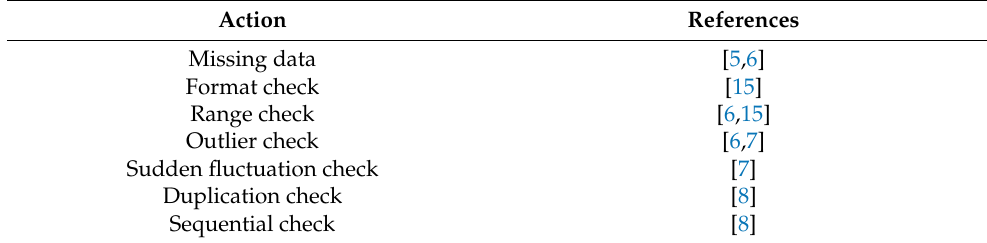
Table 2. Proposed quality control actions and related works.